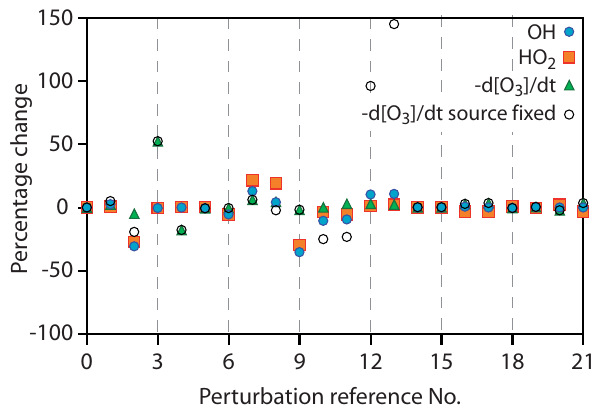
Fig. 7. Percentage change in modelled maximum OH (blue circles) and HO 2 (red squares) levels, and ozone loss rate (green triangles) for perturbations 1–21 (Table 4) of the model scheme, and change in ozone loss rate under the assumption of a fixed halogen source strength (open circles); see text for